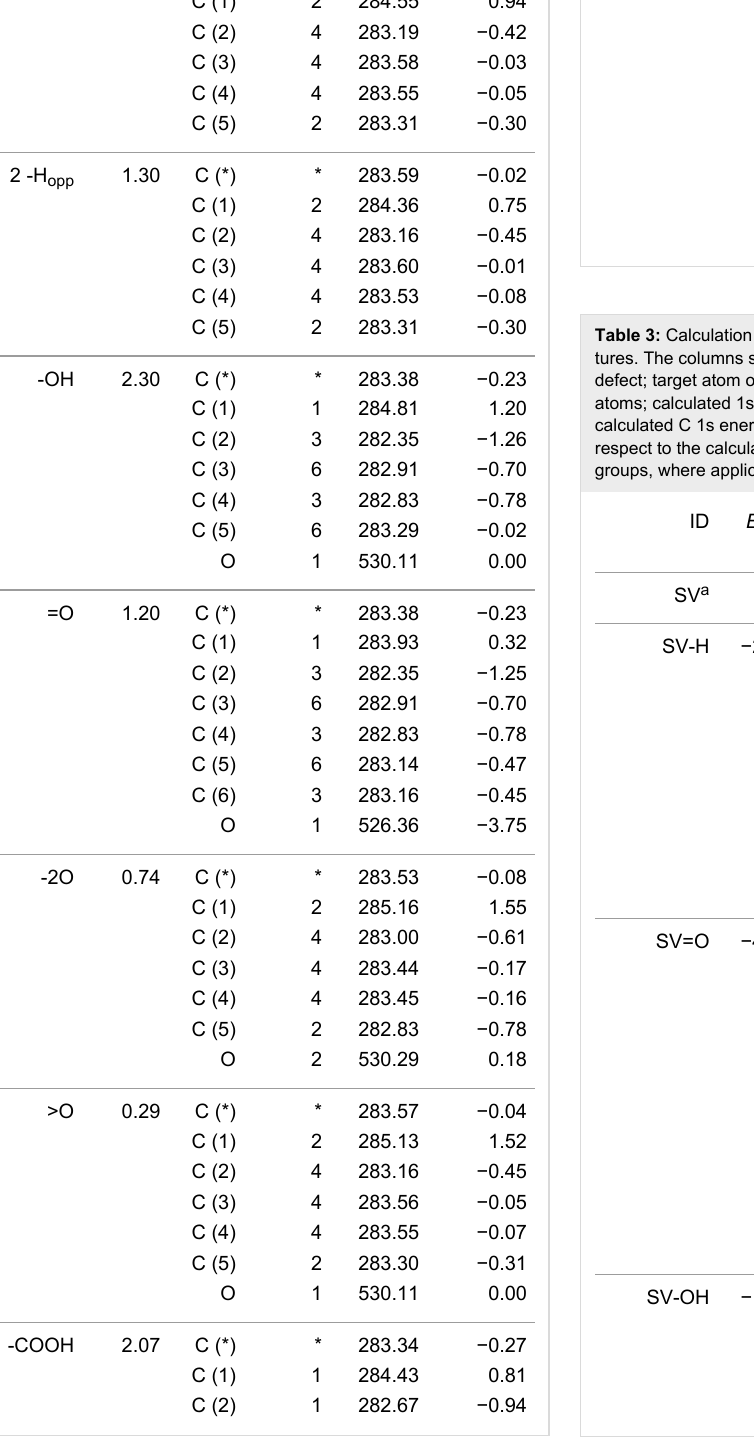
Table 2: Calculation results for the functionalized graphene structures. The columns show: system identifier; formation energy of the defect; target atom of the calculation (see Figure 2); number of target atoms; calculated 1s binding energy; C 1s BE shift with respect to the calcu- lated C 1s energy of pristine graphene or the O 1s BE shift with respect to the calculated O 1s energy of epoxide/hydroxide functional groups, where applicable. (continued)